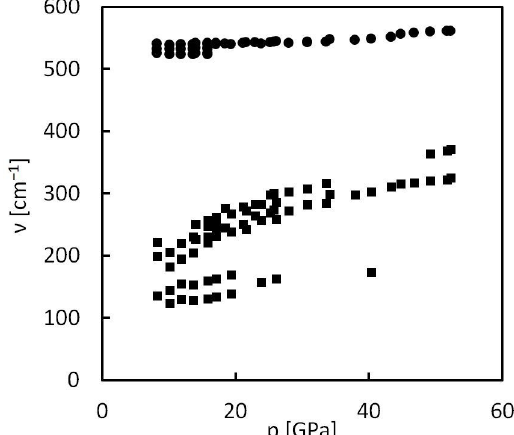
Figure 1. Pressure dependence of bands identified as originating from solid molecular chlorine, taken from one of the experimental runs. Based on ref. [35], we assign these bands as: squares—lattice phonons, circles—intramolecular Cl-Cl vibrations. (More detailed information on the assignment can be found in Supplementary Materials.)